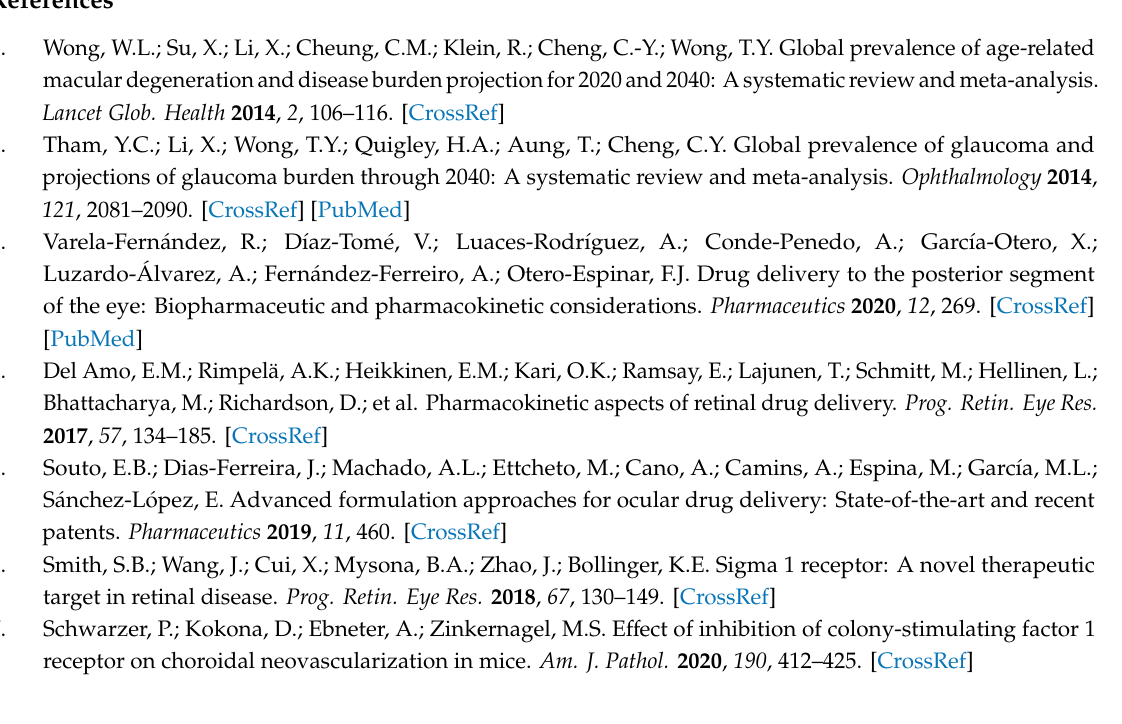
Figure S1: Step-by-step rat ocular tissue separation., Table S1: Tissue-dependent extraction ratios used for tissue sample preparation for HPLC-MS / MS analysis., Table S2: Calibration ranges (nmol / L) of HPLC-MS / MS analysis of the in vivo plasma and tissue concentration., Figure S2: Plasma concentration-time profiles of the individual Brown Norway (BN) and Wistar Han (WH) rats after oral delivery (p.o.)., Table S3: Tissue volumes used for the calculation of whole eye / plasma concentration ratios., Table S4: Average concentrations measured from ocular tissues and